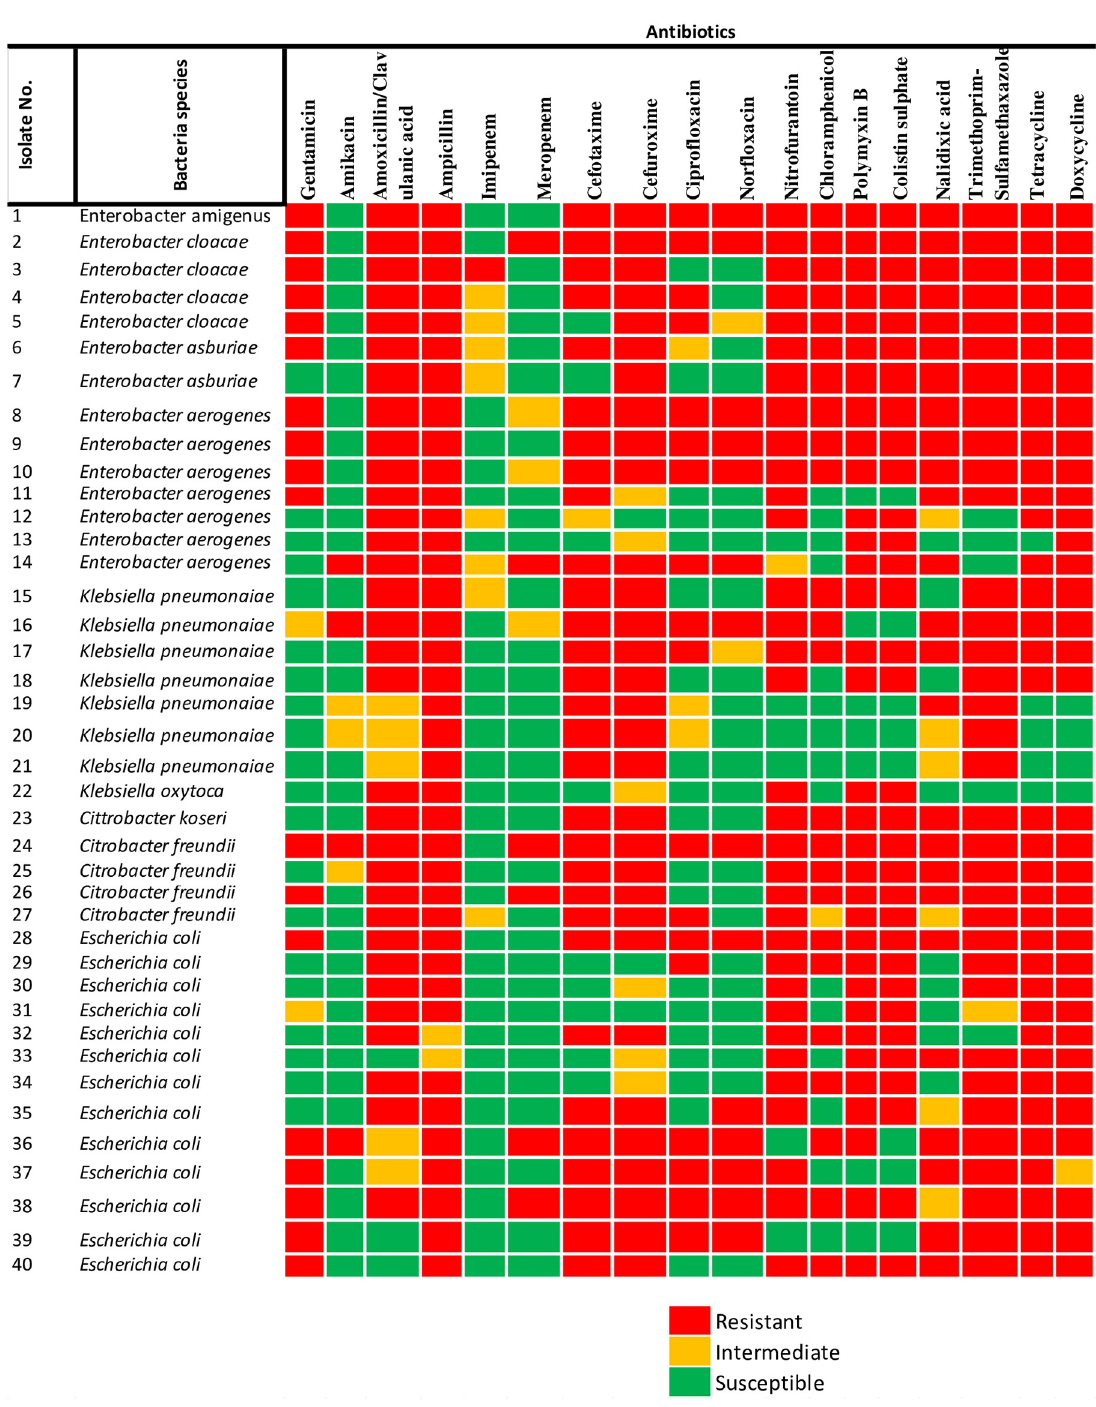
PLOS ONE | https://doi.org/10.1371/journal.pone.0238084 December7, 2020 11 /